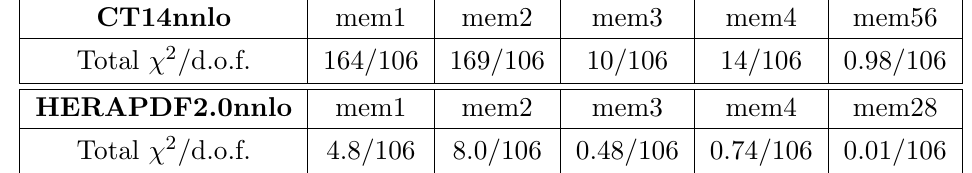
Table 1 . The (cid:31) 2 table for the CT14nnlo and HERAPDF2.0nnlo sets with rotated eigenvectors. have performed this exercise on two sets with Hessian eigenvectors: the CT14nnlo and HERAPDF2.0nnlo